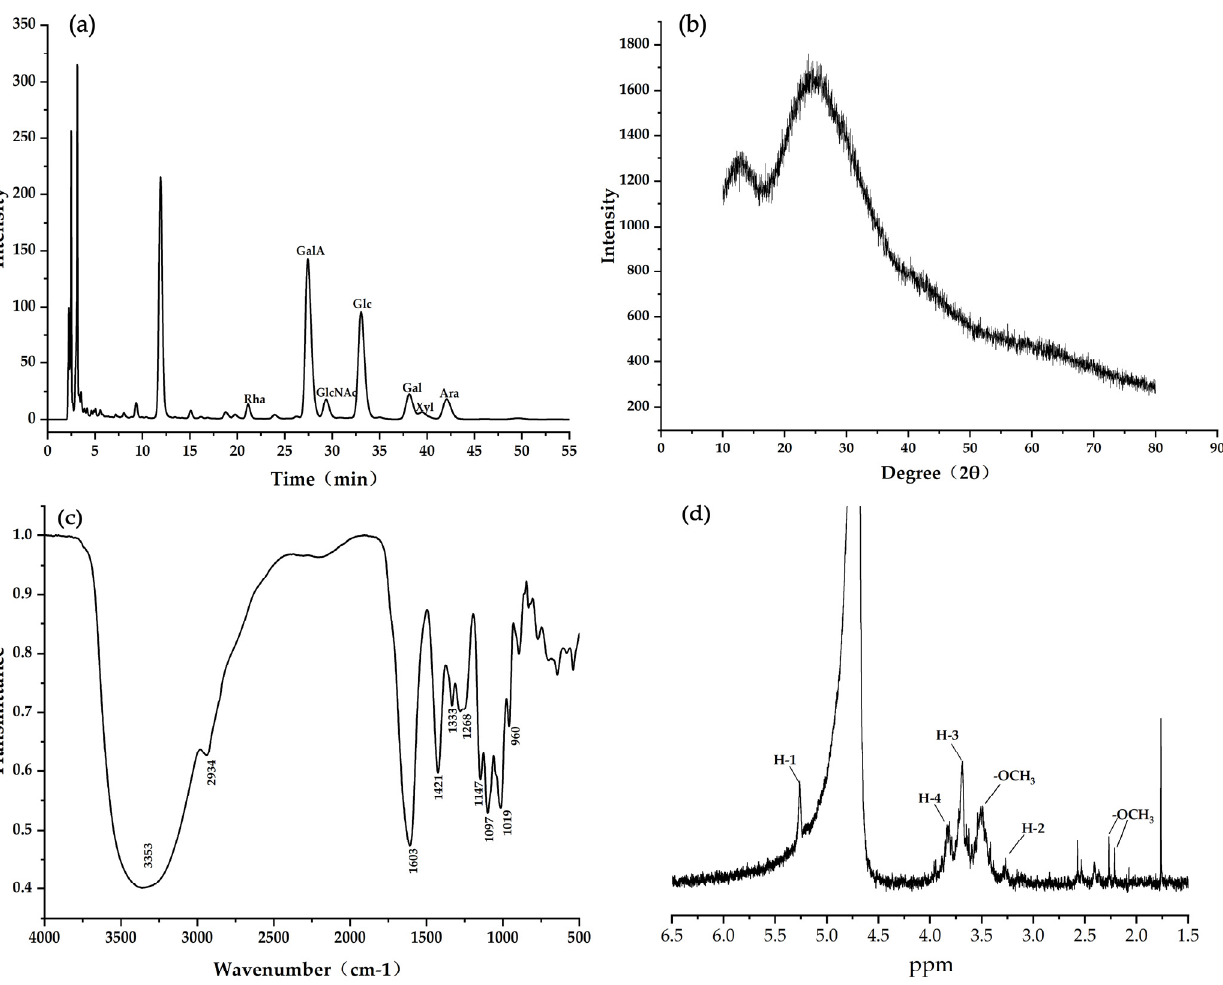
Figure 1. Structure and composition of CHP. ( a ) Monosaccharide composition; ( b ) XRD; ( c ) FT-IR; ( d ) 1 H NMR.